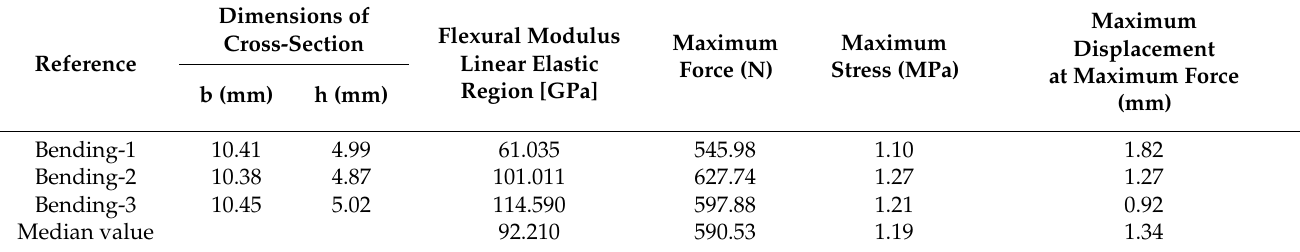
Table 4. Flexural characteristics of three-point bending tested specimens.